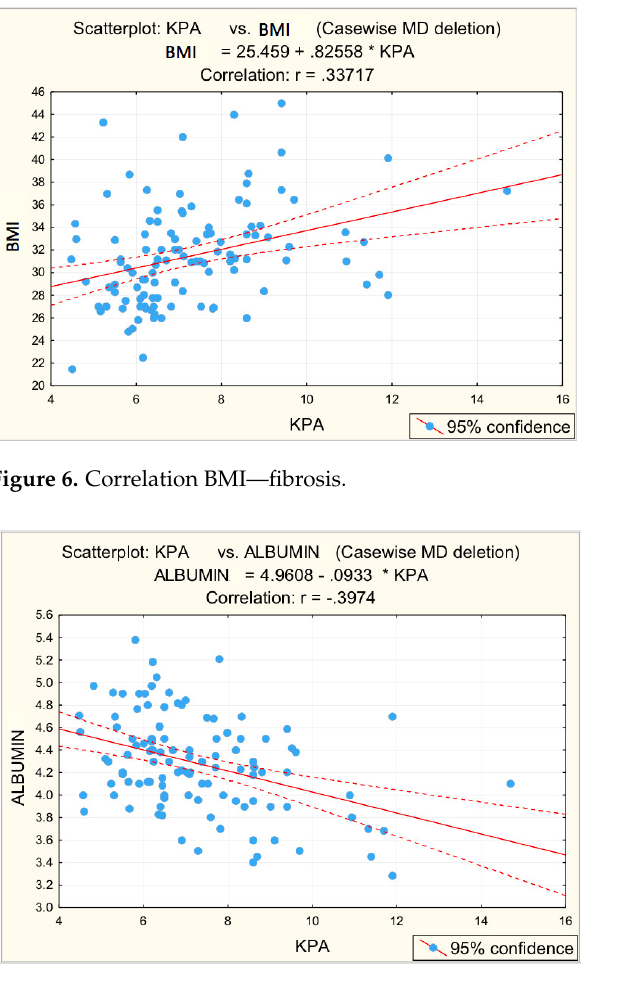
Figure 5. Correlation BSD—fibrosis .